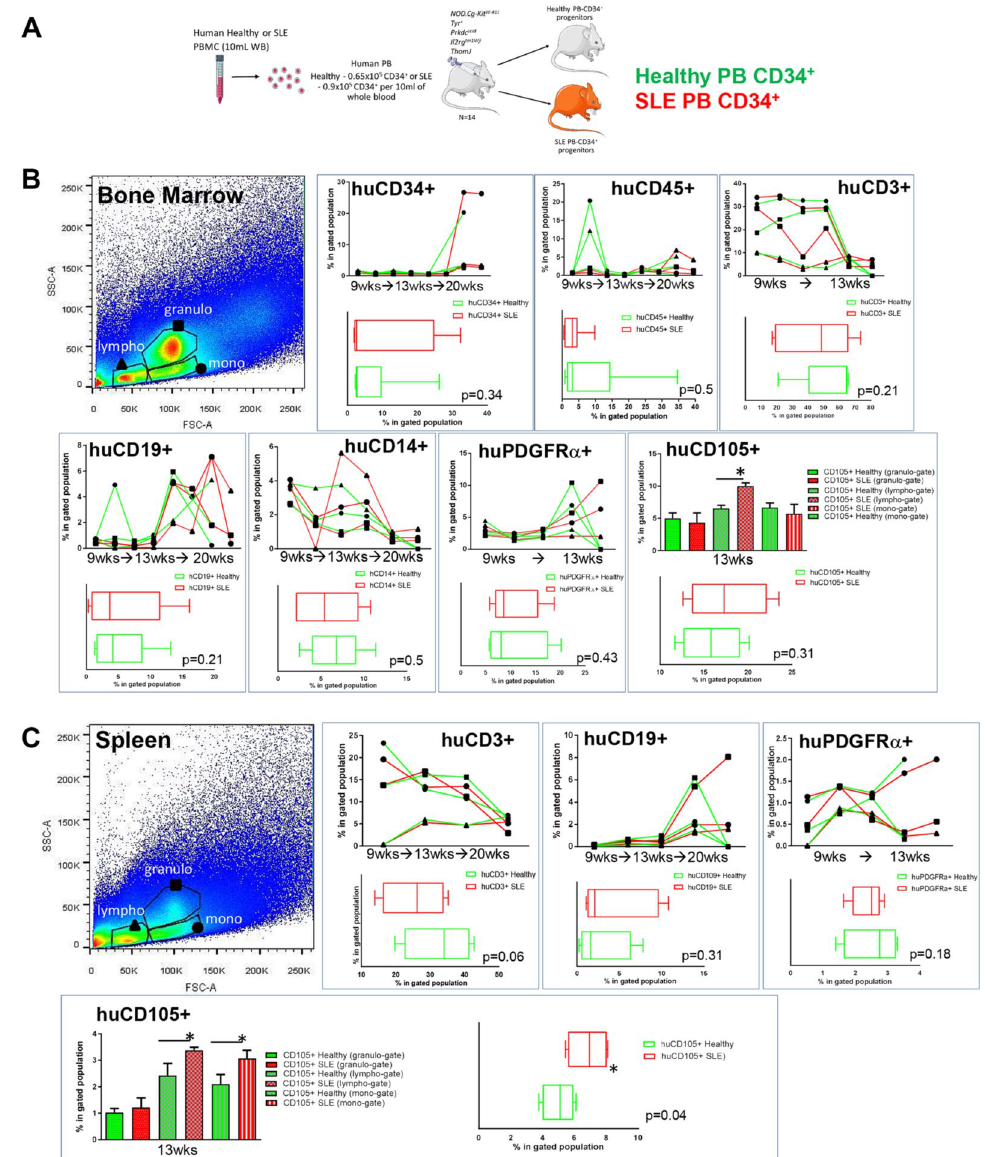
Figure 4. Altered kinetics of SLE CD34 + progenitors in BM and spleen. ( A ) Schematic representation of the xenotransplantation procedure of human PB CD34 + in 2–3-month-old mice, N = 14. ( B ) Mice were sacrificed at designated time intervals and the BM-derived cells were subjected into immunostaining with antibodies against humanonly surface markers, in order to assess human cell presence. ( C ) Mice were sacrificed at designated time intervals and the spleen-derived cells were subjected into immunostaining with antibodies against human-only surface markers, in order to assess human cell presence. Lympho-gates (triangle), granulo-gates (square) and mono-gates (circle) represent different immune cell subpopulations and therefore examined separately. Box plots indicate the average percentages of total lymphocyte populations on all time-points. Paired Student’s